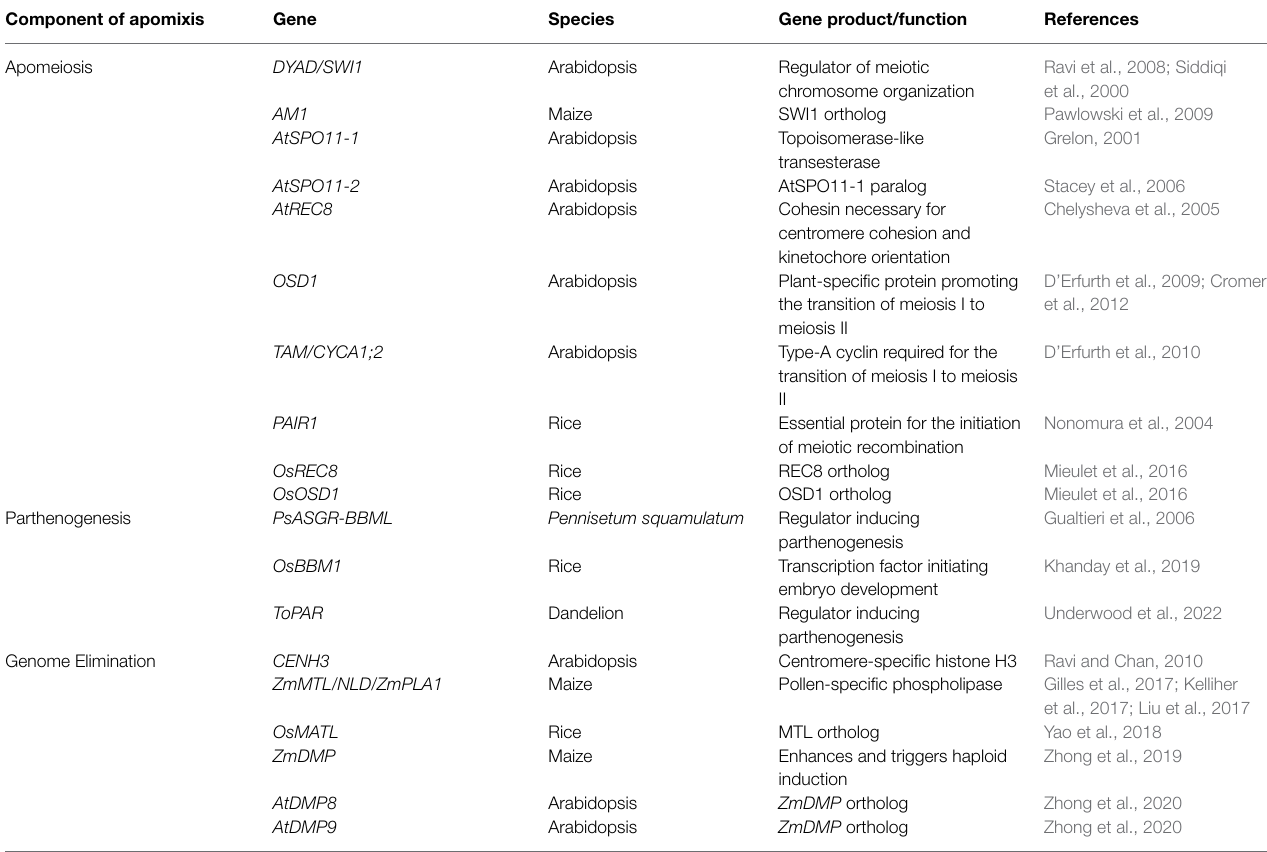
TABLE 1 | Genes and their related functions involved in apomeiosis, parthenogenesis, and genome elimination. Component of